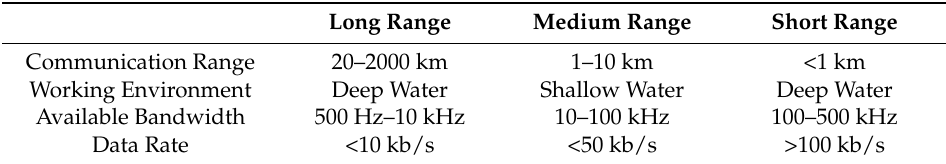
Table 1. Communication bandwidth.